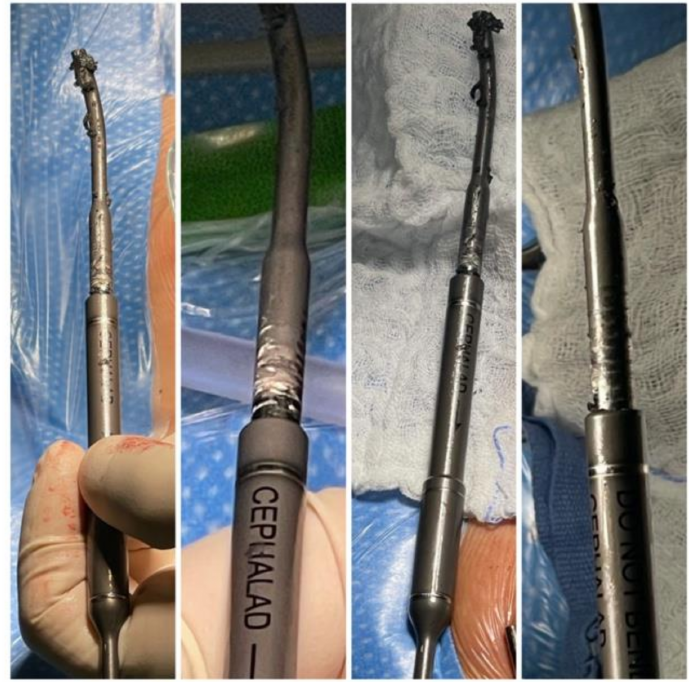
Figure 9. MCGRs and metallosis during revision